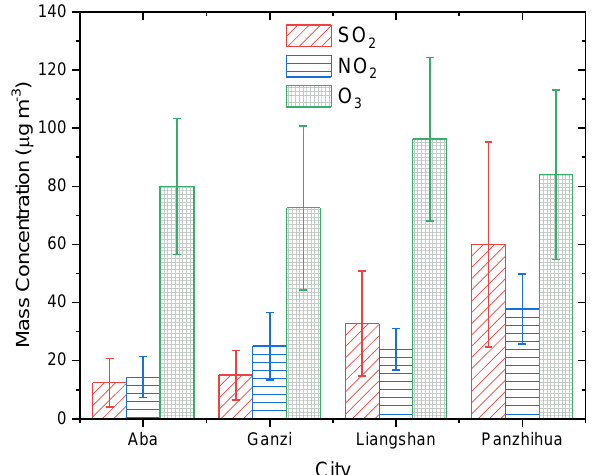
Figure 9. Multi-year mean mass concentrations of SO 2 , NO 2 , and O 3 in Aba, Ganzi, Liangshan, and Panzhihua.